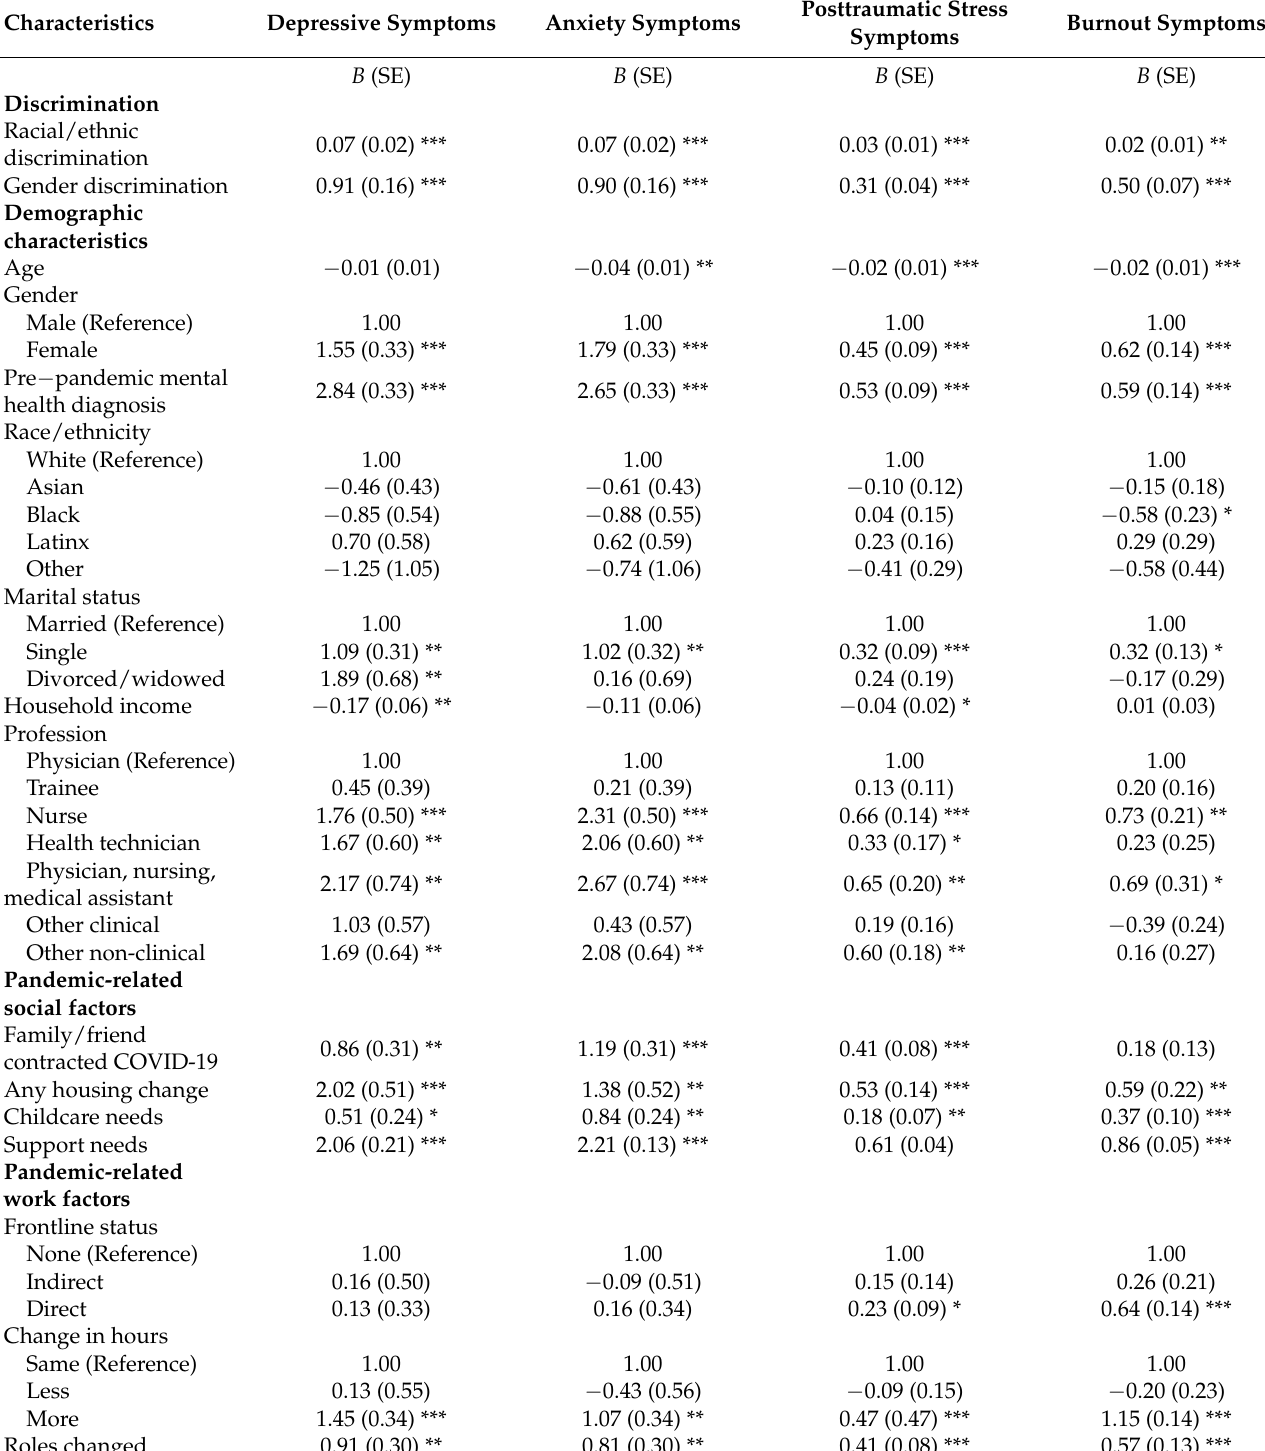
Table 2. Unadjusted linear regression models for discrimination and mental